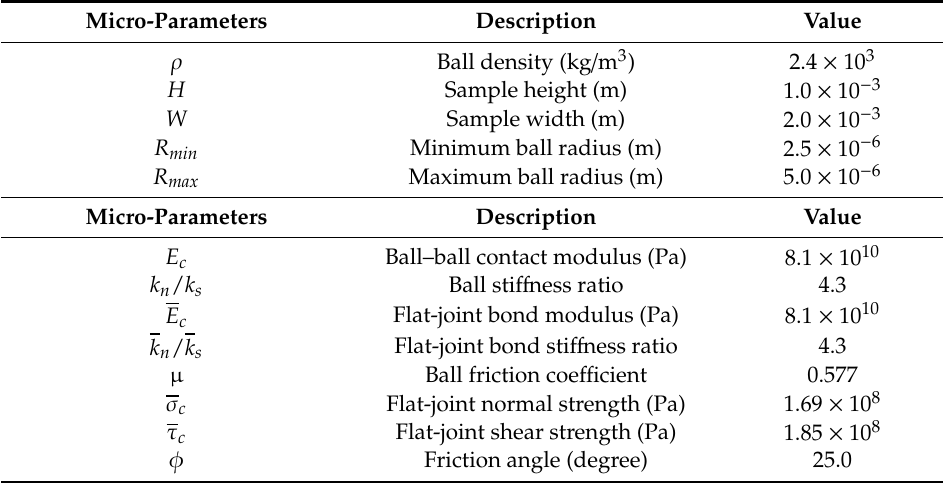
Table 1. Macro- and micro-parameters of the synthetic specimen.